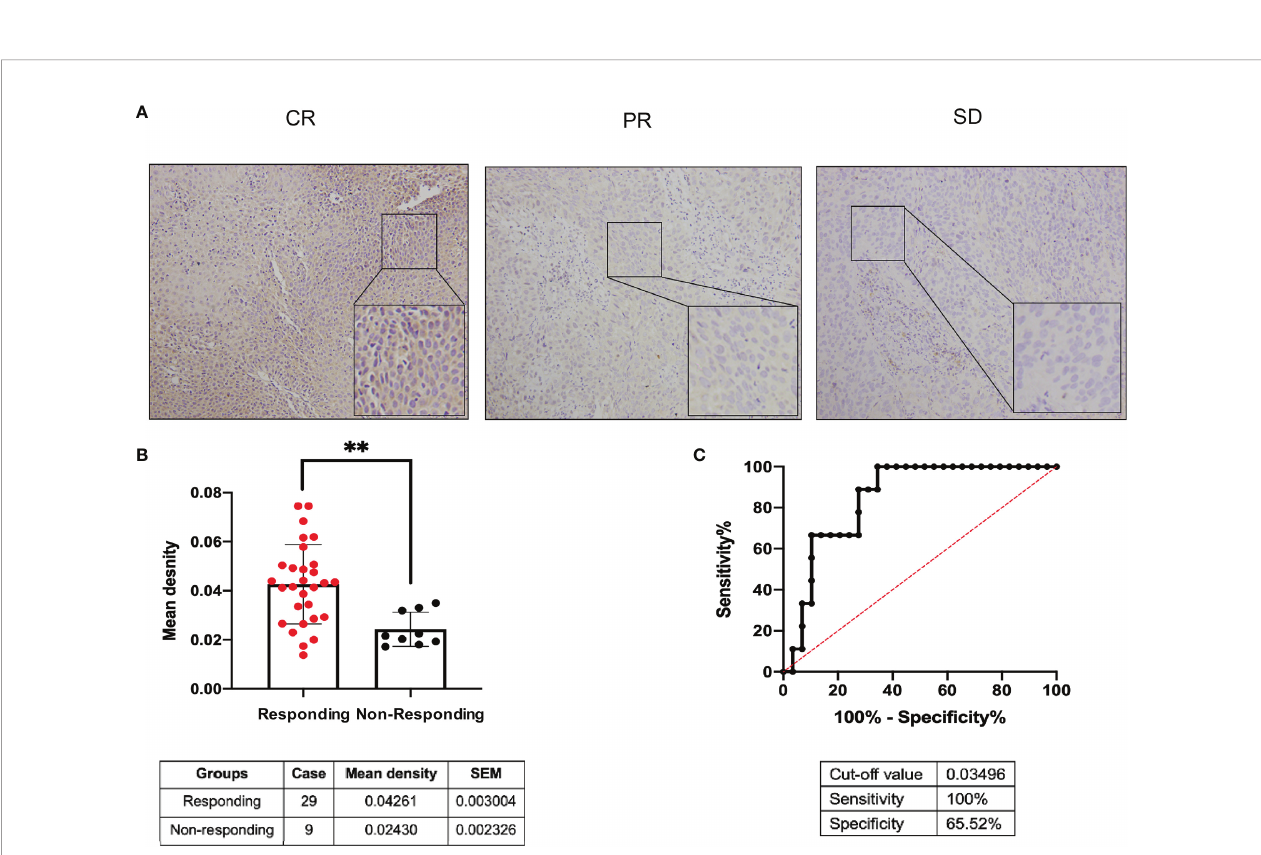
FIGURE 5 | Predictive value of MMS22L for different responses to NCRT in patients with ESCC. (A) MMS22L IHC in representative tumour tissues. (B) The mean density of the responding group and nonresponding group from all 38 cases who received NCRT is summarised in the table below. (C) ROC curve for evaluating the predictive value of MMS22L for ESCC patients with NCRT. The AUC was 0.847, the sensitivity was 100%, the speci fi city was 65.52%, and the cutoff value was 0.03495 (** p < 0.01). NCRT, neoadjuvant chemoradiotherapy; AUC, area under the ROC curve; ROC, receiver operating